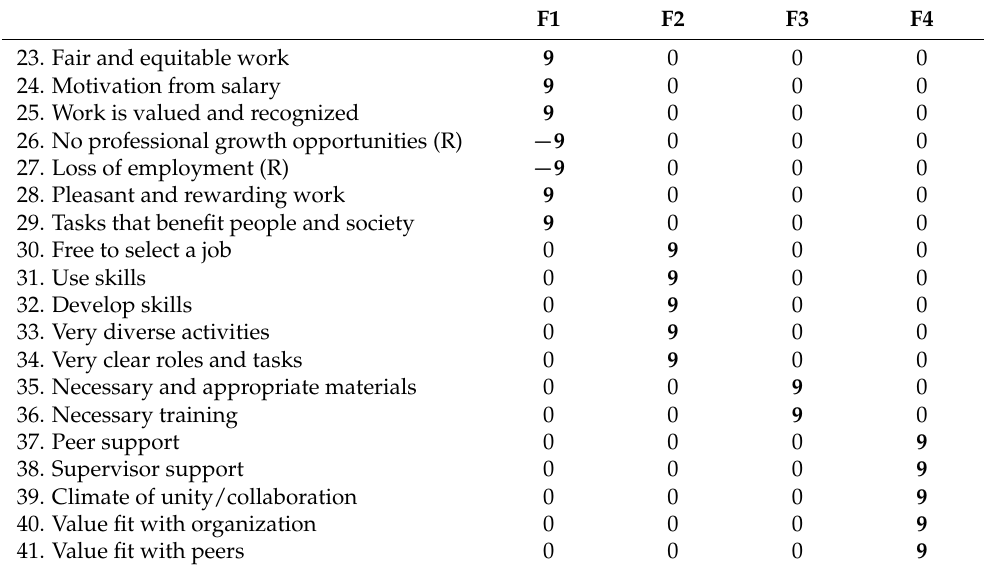
Table A2. Positive psychosocial resource factors: target matrix for the first